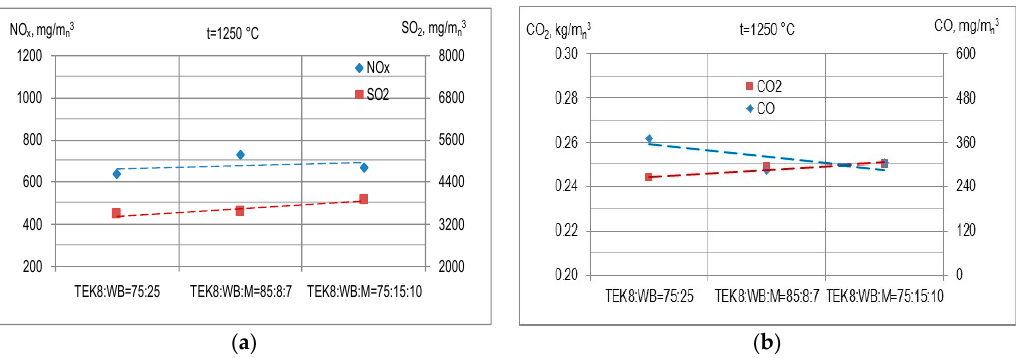
Figure 7. Emissions for different biomass co ‐ firing with coal TEK8, ( a ) NO x and SO 2 emissions ( b ) CO and CO 2 emissions.